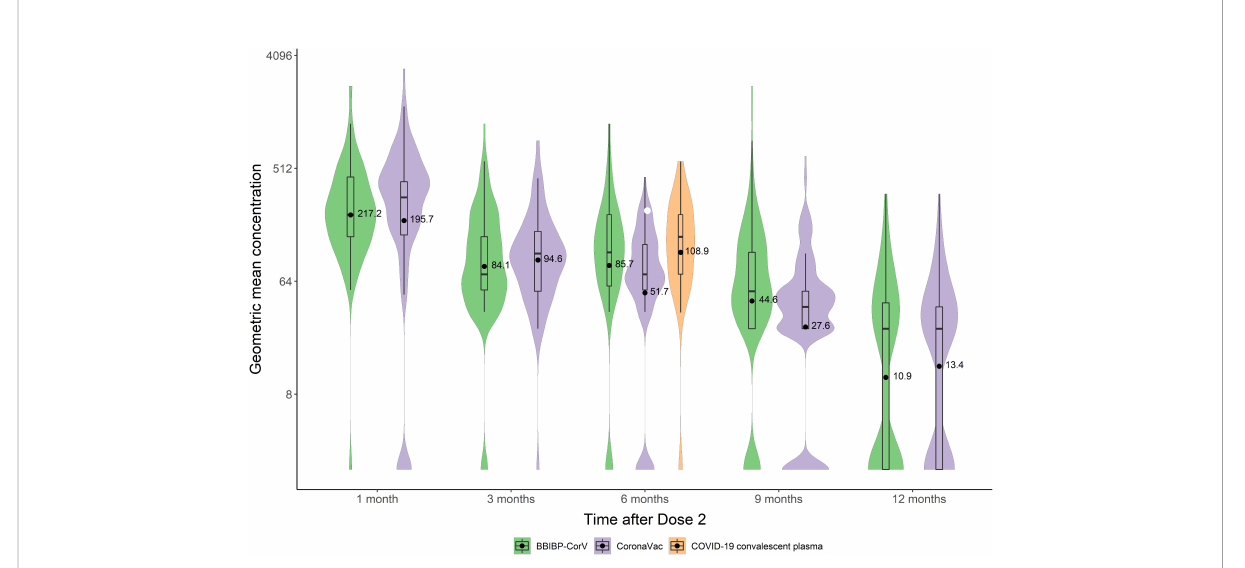
FIGURE 3 GMCs of nAb at different time points after immunization with inactivated COVID-19 vaccine and COVID-19 convalescent